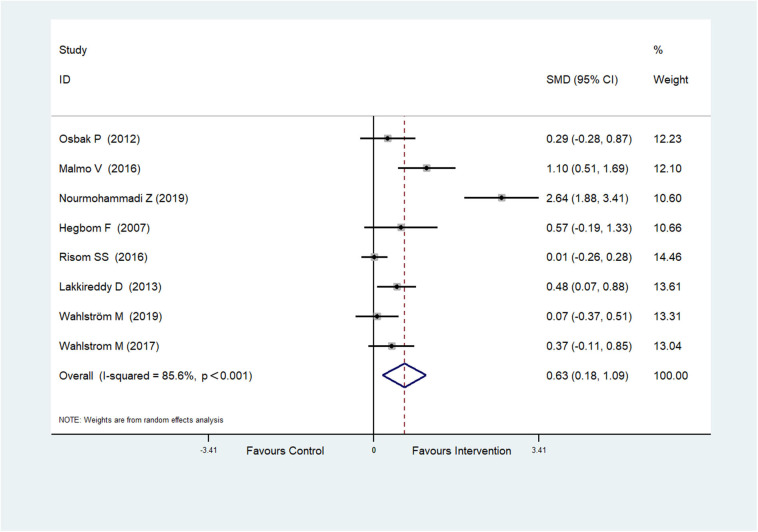
Forest plot shows the ES of physical exercise on Physical Functioning in AF patients.